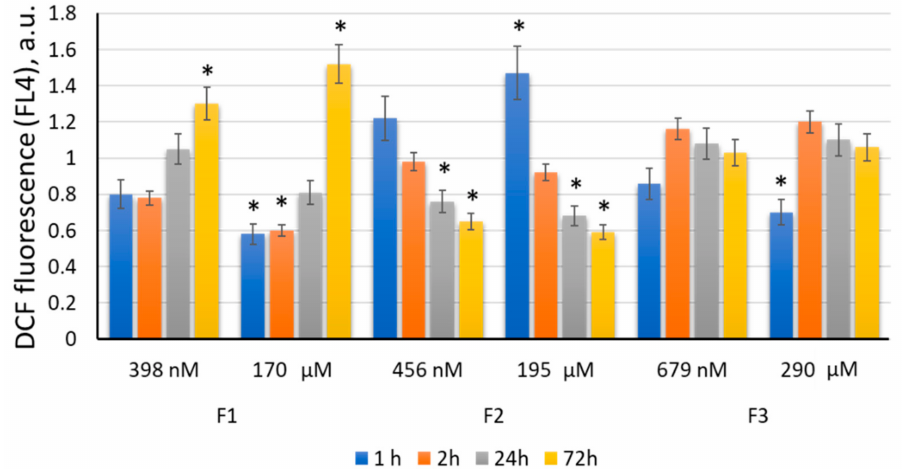
Figure 12. ROS levels in cells expressed as a ratio of DCF synthesis rate constants after F2 (195 µ M) exposure related to blank cells (the cells cultured without the fullerene); (*) denotes significant differences according to the Mann–Whitney test ( p < 0.05). In blank experiments, cells were incubated without the